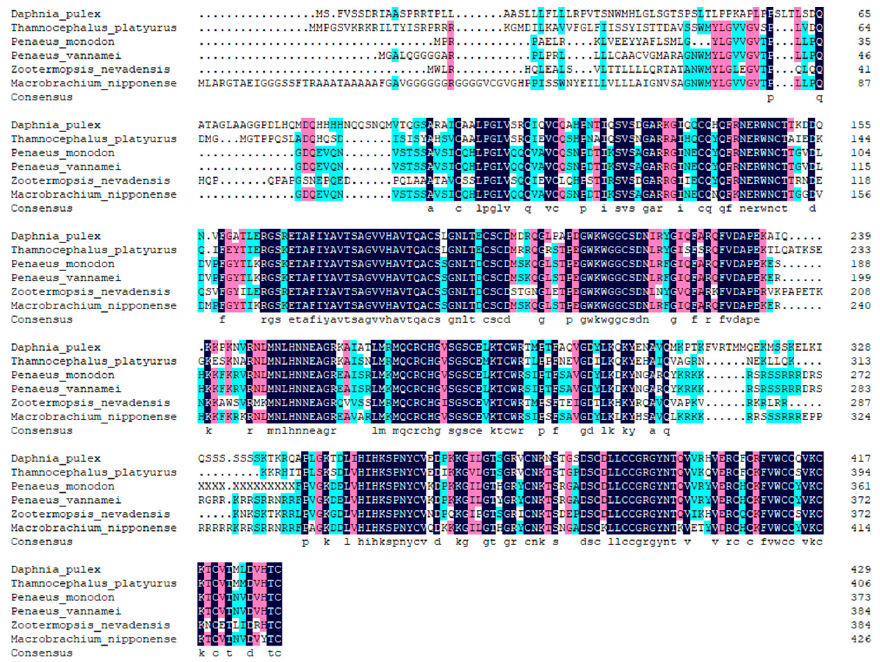
Figure 4. Amino acid sequence alignment of Wnt16 with homologs from other species. All the sequences used in this analysis had the GenBank accession numbers as follows: Daphnia magna (XP_032781217.1), Thamnocephalus platyurus (ALL53298.1), Penaeus monodon (XP_037793890.1), Penaeus vannamei (ALO81632.1), Zootermopsis nevadensis (XP_021925369.1), Cryptotermes secundus (XP_023712832.1), Macrobrachium nipponense (QIV66986.1), Dinothrombium tinctorium (RWS07889.1) and Centruroides sculpturatus (XP_023224171.1).